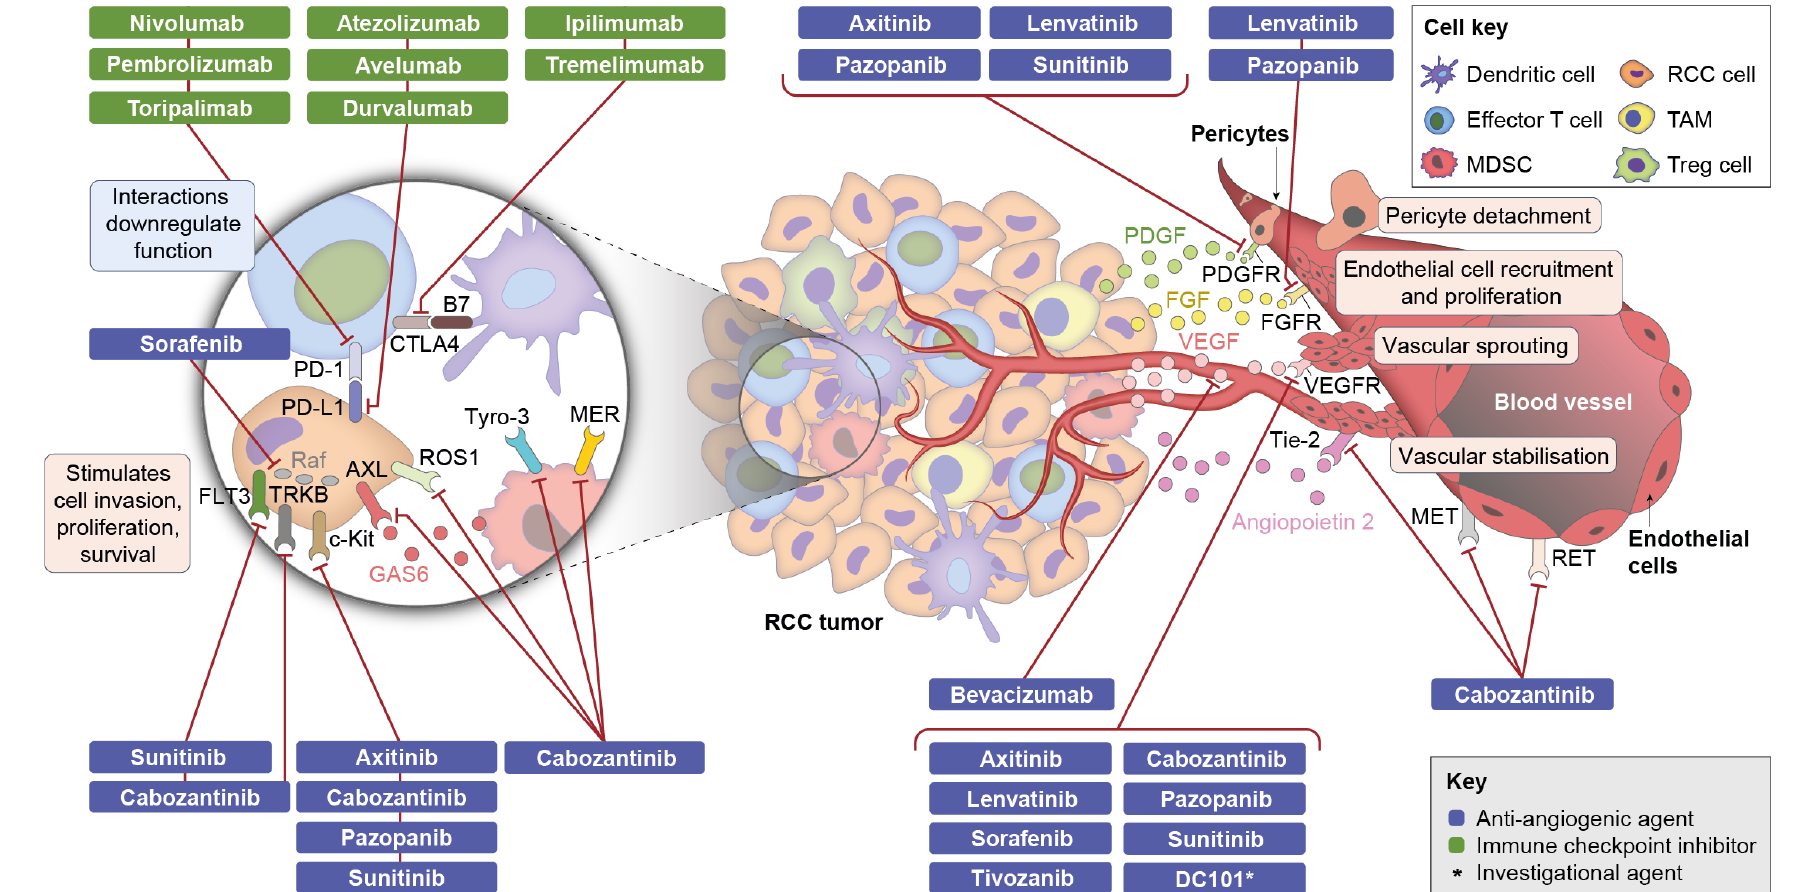
Figure 2. Effects of RCC therapies within the tumour microenvironment CTLA-4, cytotoxic T-lymphocyte-associated protein 4; FGF, fibroblast growth factor; FGFR, FGF receptor; FLT3, FMS-like tyrosine kinase 3; GAS6, growth arrest-specific 6; MDSC, myeloid-derived suppressor cell; MET, mesenchymal-epithelial transition factor or hepatocyte growth factor receptor; PD-1, programmed cell death protein 1; PD-L1, programmed death-ligand 1; PDGF, platelet-derived growth factor; PDGFR, PDGF receptor; Raf, proto-oncogene serine/threonine protein kinase; RCC, renal cell carcinoma; RET, rearranged during transfection receptor; TAM, tumor-associated macrophage; Tie-2, tyrosine kinase with immunoglobulin and epidermal growth factor homology domains-2; Treg, regulatory T cell; TRKB, tropomyosin receptor kinase B; Tyro-3, tyrosine-protein kinase receptor TYRO3; VEGF, vascular endothelial growth factor; VEGFR, VEGF receptor.